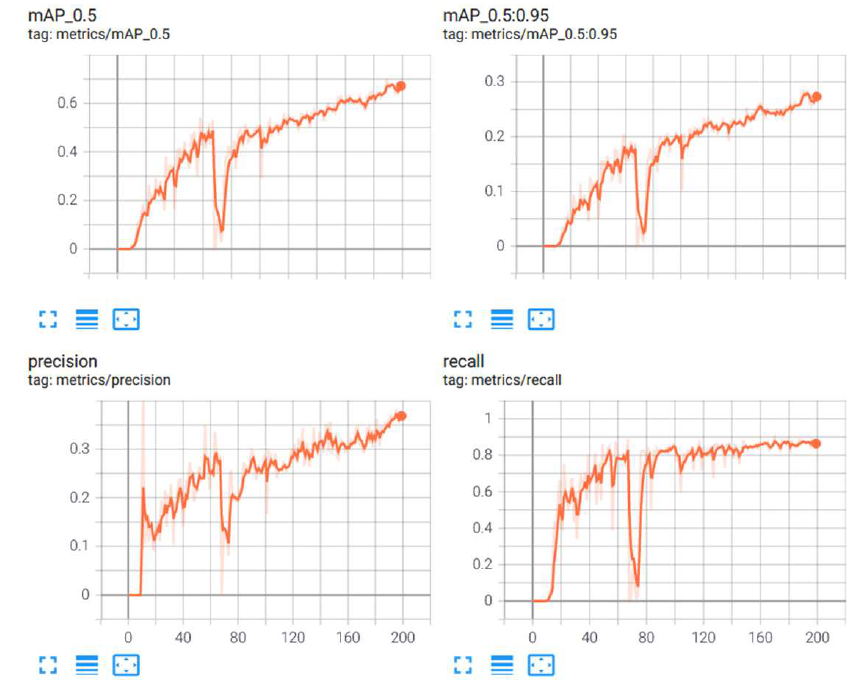
Figure 10. Metrics for stage classification model: scaled YOLOv4.